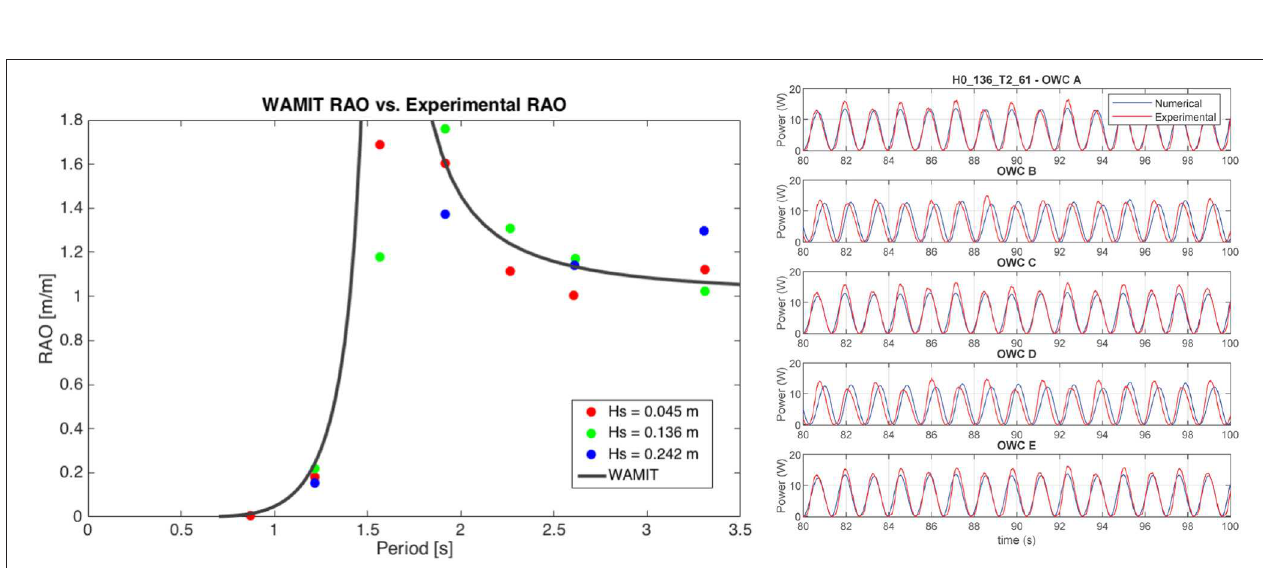
FIGURE 10 | Experimental and numerical results for an array of five fixed OWCs. (Left) Response amplitude operator from WAMIT compared to experimental data (Sharp et al., 2017). (Right) Power absorption computed by a WEC-Sim model compared to experimental results (Bosma et al., 2019).